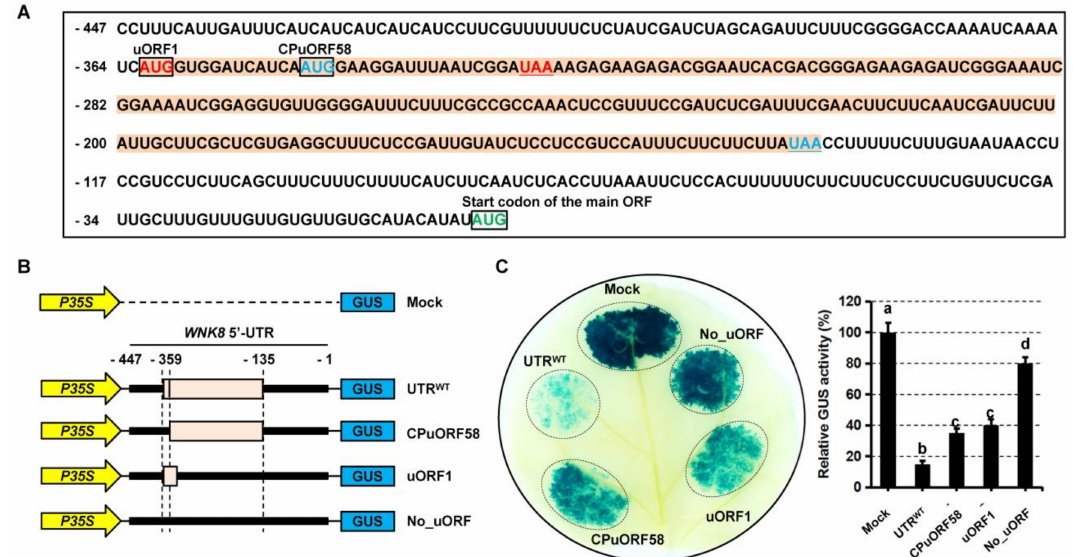
Figure 4. Effects of uORF disruptions in WNK8 5 (cid:48) -UTR on downstream gene expression. ( A ) Nucleotide sequence of the WNK8 5 (cid:48) -UTR. Sequences in yellow represent uORFs. The start codons for two uORFs and the main ORF are colored and in frame with boxes. Stop codons of uORFs are underlined and highlighted in color same to that of corresponding start codons. ( B ) Schematic representations of the constructs for transient expression. Thick black lines represent the WNK8 5 (cid:48) -UTR and pink boxes represents the uORFs, respectively. The constructs at the right represent point mutations (AUG to AAG) in the start codons of WNK 8 5 (cid:48) -UTR. ( C ) Transient expression analysis in tobacco leaves with the DNA constructs. Illustrative photograph of tobacco leaves transformed with the indicated constructs and visualized with GUS histochemistry. In addition, relative reporter activities are shown at right and different groups marked with letters represent the 0.05 significance